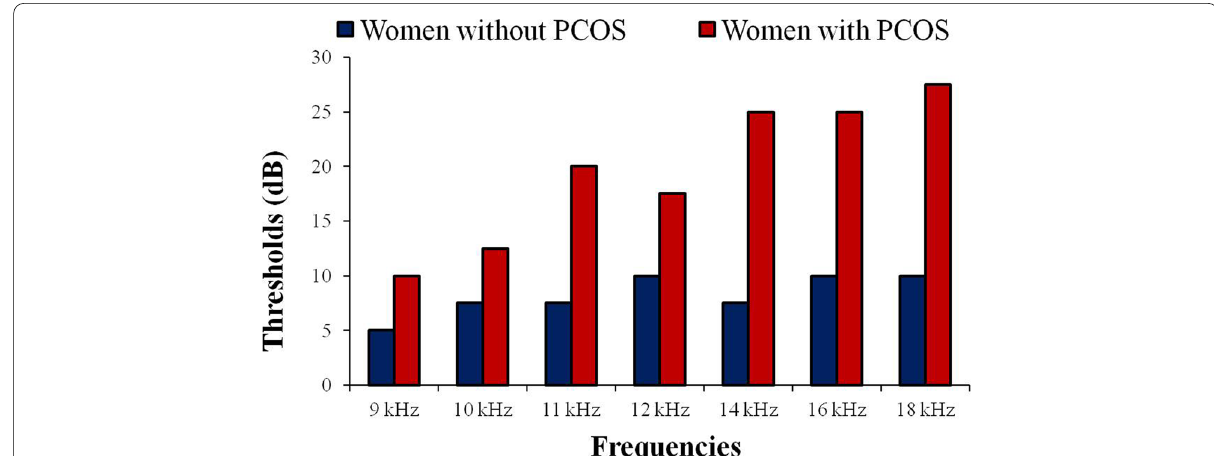
Fig. 1 Mean and standard deviation of the high-frequency thresholds obtained from women with and without PCOS